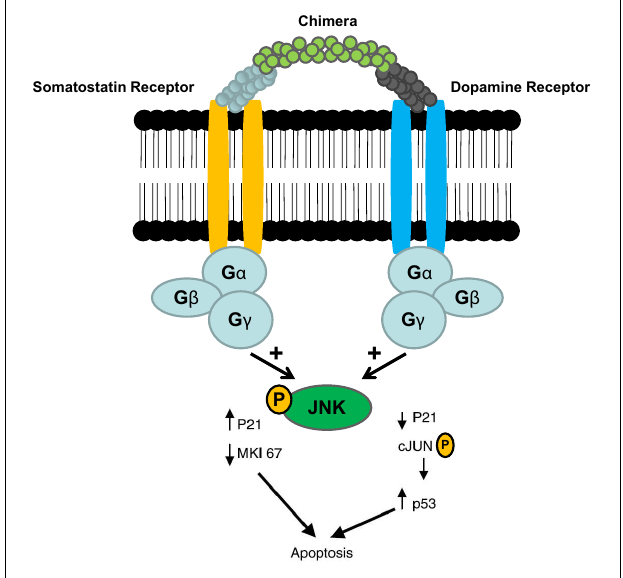
FIGURE 1 | Somatostatin/dopamine chimera-induced dimerization of somatostatin and dopamine receptors [Adapted from Ref.